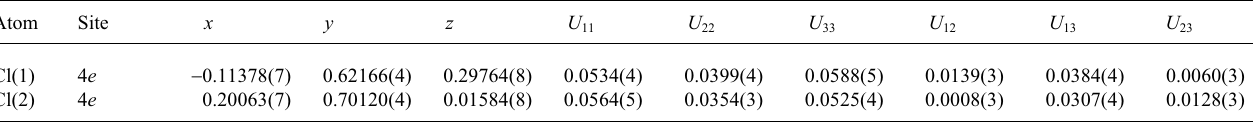
Table 3. Atomic coordinates and displacement parameters (in Å 2